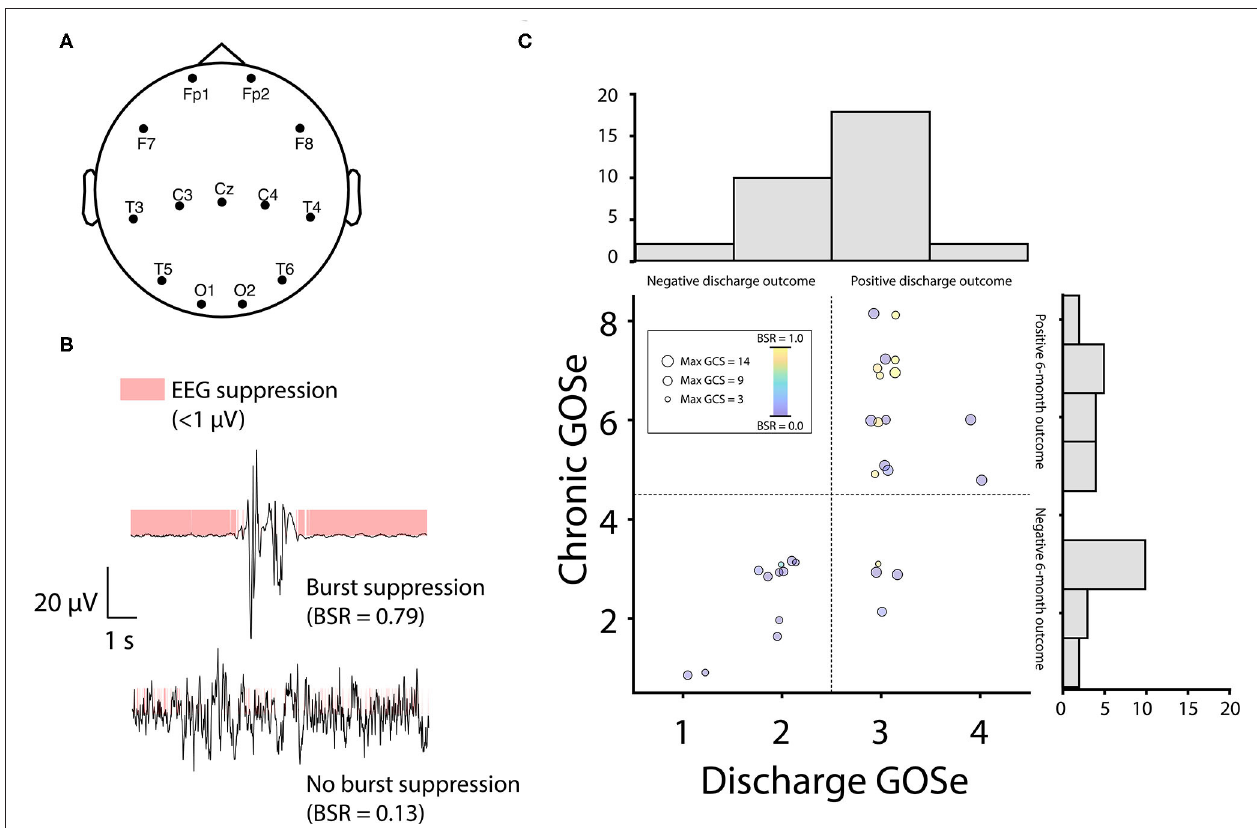
FIGURE 1 | EEG burst-suppression positively predicts outcomes at chronic follow up. (A) EEG signals were recorded from 13 channels common to all patients. Channel placement was frequently modified from standard positions (shown above) to accommodate bone flaps and injury sites in individual patients. (B) The EEG burst suppression ratio (BSR) was computed as the proportion of clean signal with a rectified amplitude < 1 µ V (mode across channels). (C) Outcomes were assessed using the Glasgow Outcome Scale extended (GOSe) and were divided at discharge and chronic timepoints using median splits (dotted lines, GOSe scores are scattered with jitter to avoid overlap). Patients with burst-suppression (red circles) were overrepresented in the upper half of each median split (blue circles = no burst-suppression; circle size is proportional to patient’s highest Glasgow Coma Scale score). Note that 2 patients missing chronic GOSe scores (Patients 4 and 10, Table 1 ) are not shown in the scatter plot but are represented in the discharge GOSe histogram. GOSe scores at discharge showed low spread, with most patients either scoring 2 (vegetative state) or 3 (low severe disability). Similarly, chronic GOSe scores showed a bimodal distribution with peaks flanking a large dip at 4 (upper severe disability). Owing to this fact, we opted for a median split on scores (discharge: 1-2 vs. 3-4; chronic: 1-4 vs. 5-8) to create dichotomous outcome variables for logistic regression. In the upper half of both the discharge and chronic GOSe median split, 40% of patients displayed BSR > 0.5, vs. 0% (discharge) and 6.7% (chronic) of patients in the lower half of the GOSe